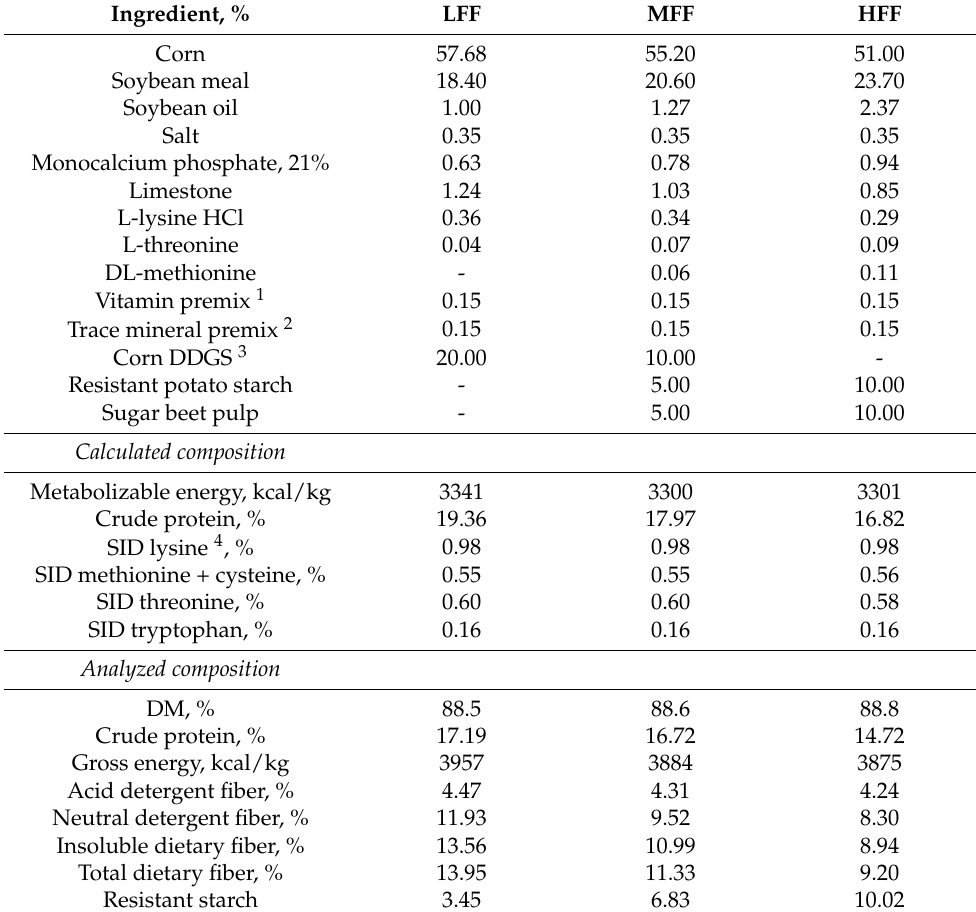
Table 1. Diet composition, as